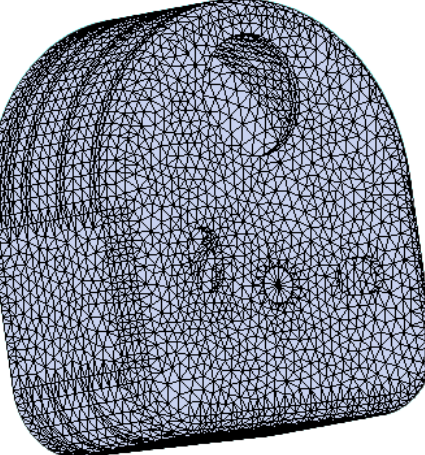
Figure 6. Meshing diagram of rotating electromagnet. Through the simulation test, the size of the retaining force and the total change of the difference of the retaining force under each parameter are calculated. For example, in the first simulation experiment, the thickness of the permanent magnet is set as a single variable and divided into 11 sizes of 3, 3.1, 3.2, . . . , and 4. The remaining variables are designed as the original size. When the thickness of the permanent magnet is 3 mm, the simulation results are shown in Figure 7.